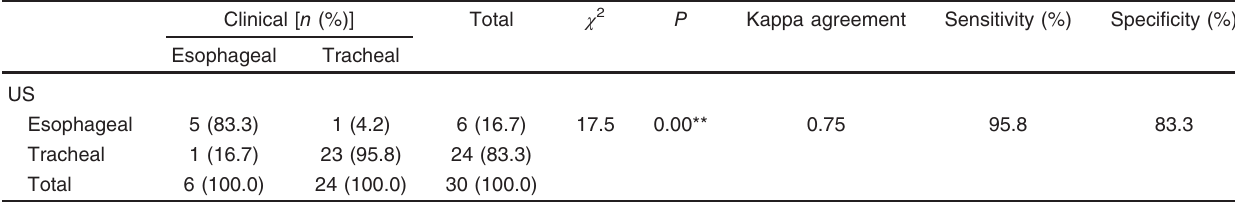
Table 2 The sensitivity and specificity of ultrasonography with regard to the clinical method as gold